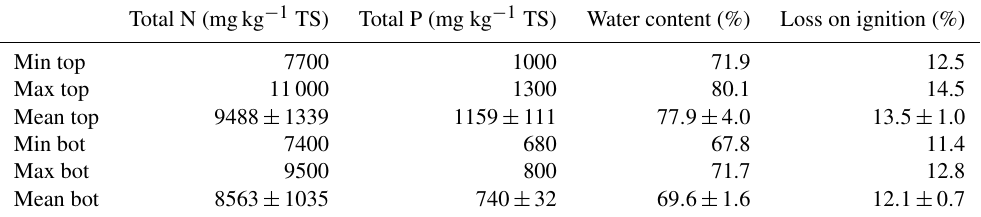
Table 1. Composition of nutrients and the percentage of organic-matter and water content in sediments (mean ± SD; n = 8). TS: total